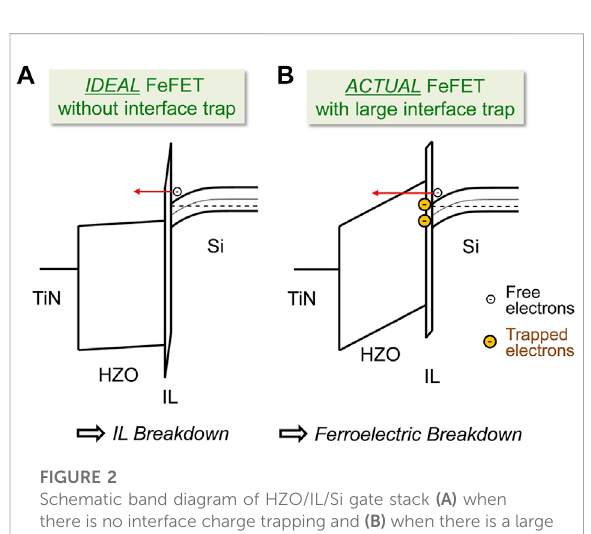
Schematic band diagram of HZO/IL/Si gate stack (A) when there is no interface charge trapping and (B) when there is a large amount of interface charge trapping, where 90% of induced electrons are trapped. Here, the Si band was scaled in the depth direction by 1:100 ratio to make the band bending